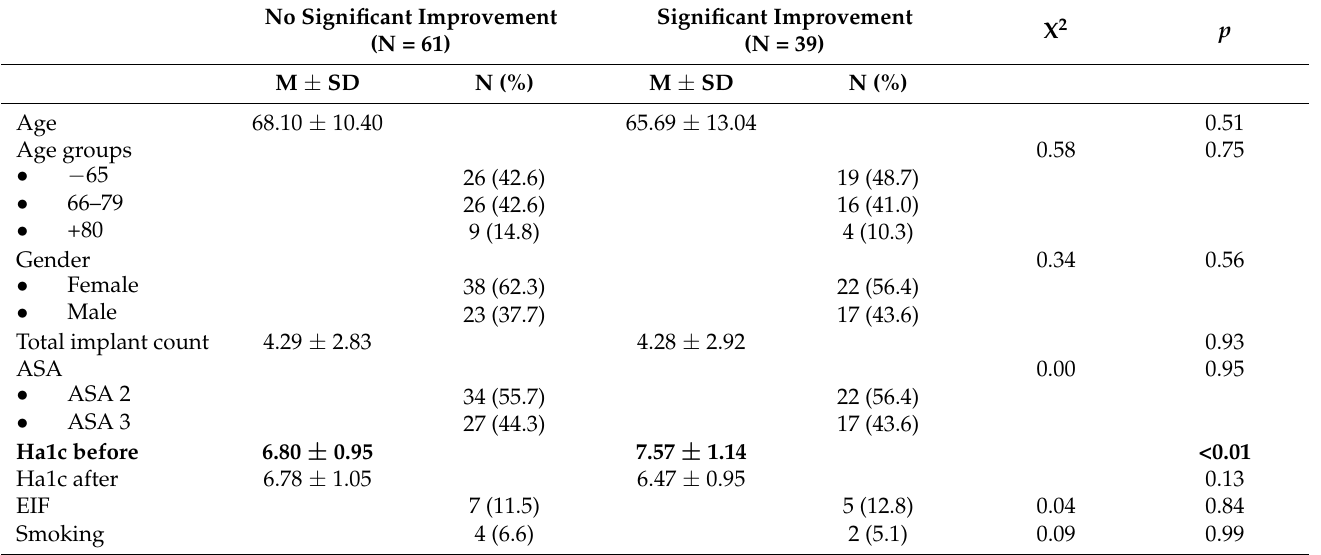
Table 2. Univariate analysis (individual level).